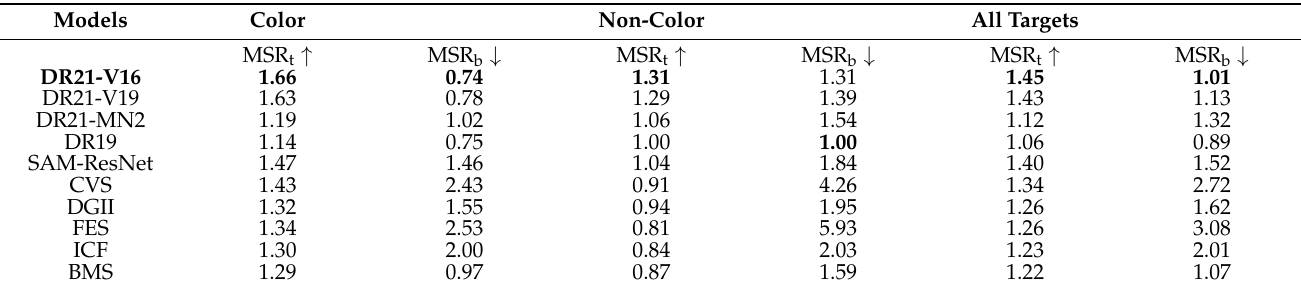
Table 8. Comparing results between several models (SAM-Resnet, CVS, DeepGaze II, FES, ICF, and BMS) and DR family ( DR19 and DR21 in the version VGG16, VGG19, and MobileNetV2). For MSR t , higher is better, For MSR b , lower is better.